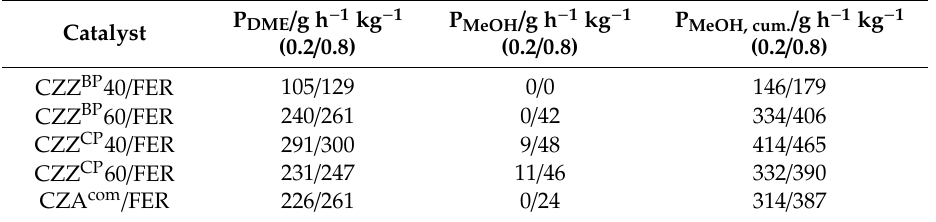
Table 4. Dimethyl ether (DME) (P DME ), MeOH (P MeOH ) and cumulative MeOH (P MeOH, cum. ) productivities of the CZZ catalysts and CZA com as physical mixtures of sieve fractions with H-FER